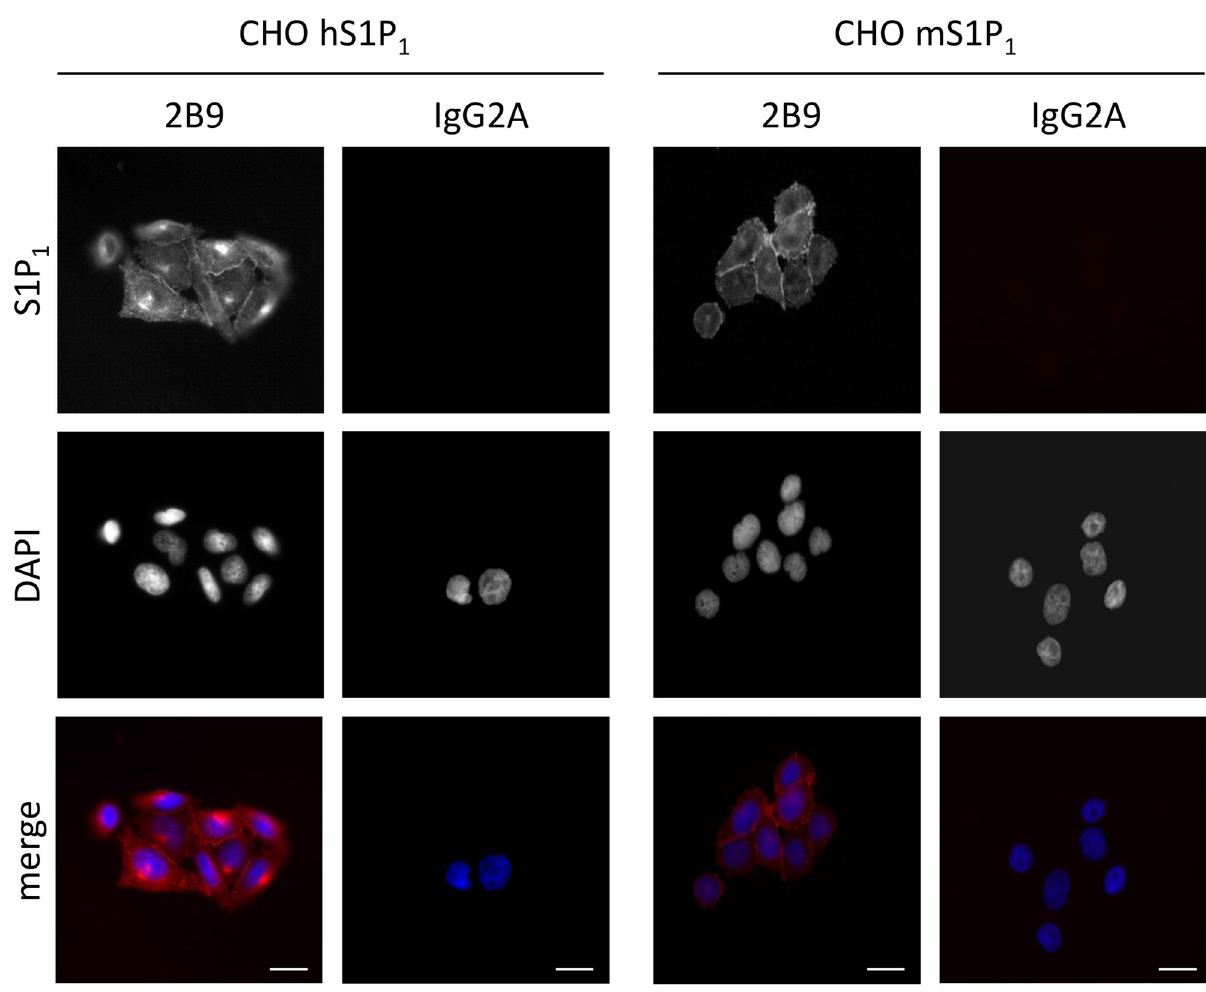
Fig 6. 2B9 recognizes human and mouse S1P 1 . CHO cells stably expressing human (CHO hS1P 1 ) or mouse (CHO mS1P 1 ) S1P 1 receptors were fixed and stained with 2B9 (red) or control IgG2A (red) antibodies (1:100, w/v). DNA was stained with DAPI (blue). Images are representative of the population examined. Scale bar, 10 μ